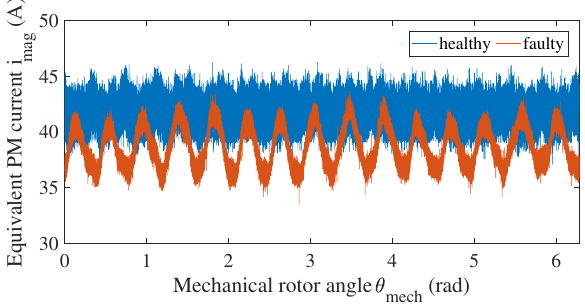
Figure 17. Effect of the demagnetization fault on the equivalent permanent magnet current i mag